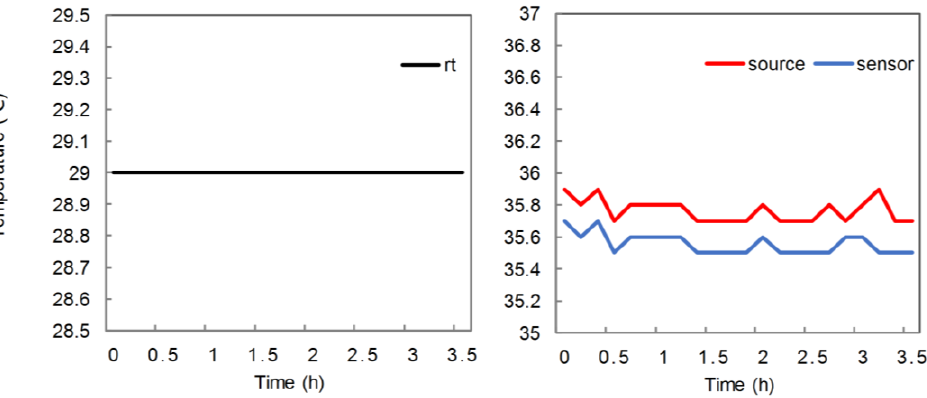
Figure 4. Thermal changes in typical LED source and photo sensor, Probe 3 Channel 1.